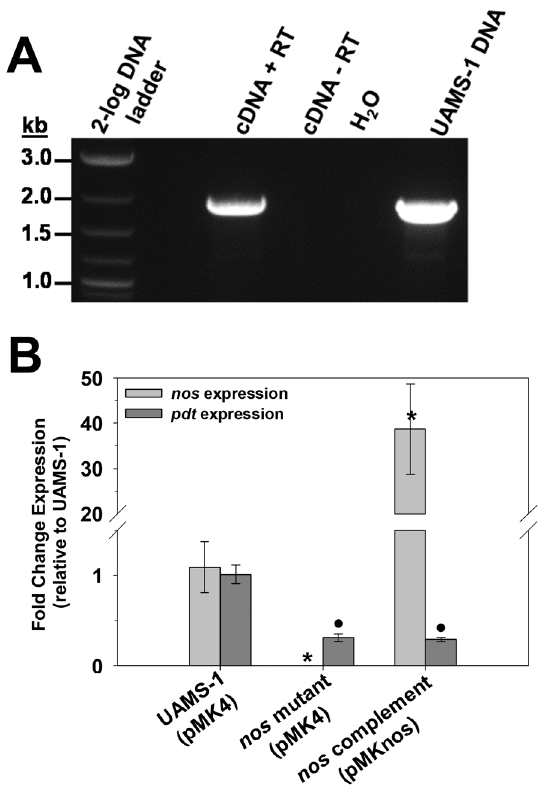
Figure 3. Co-transcription of nos and pdt genes. A: 0.750 m g of UAMS-1 RNA isolated from 6-hour low-oxygen cultures was converted to cDNA using the iScript select cDNA kit (BioRad) and primer pdt5-R. As a control, these reactions were also performed in the absence of reverse-transcriptase (RT) enzyme, to check for genomic DNA contam- ination of the RNA. Equal amounts of RT + and RT- cDNA samples, as well as UAMS-1 genomic DNA and no template control, were used as templates in a PCR reaction containing the primer pair nos5-F/pdt5-R, which amplifies a product spanning the region between the nos start codon and pdt stop codon. Data are representative of results obtained from RNA isolated from n=3 biological replicates. B: Total RNA was isolated from n=3 biological replicates each of UAMS-1 (pMK4; wild- type), KR1010 (pMK4; nos mutant), and KR1010 (pMKnos; nos complement) grown at 37 u C for 6 hours under low-oxygen (0 RPM, 7:10 volume-to-flask ratio) conditions. Quantitative real-time PCR was performed on reverse-transcribed cDNA from each sample using nos and pdt -specific primers. The Livak (2 - DD Ct ) method was used to determine relative fold change of expression of each gene, using measured sigA expression as the reference gene and the 2 hour aerobic sample as the calibrator. Error bars = SEM. *denotes statistical significance of nos expression relative UAMS-1 (Student-Newman-Keuls Test, p , 0.05); N denotes statistical significance of pdt expression relative UAMS-1 (Student-Newman-Keuls Test, p , 0.05).